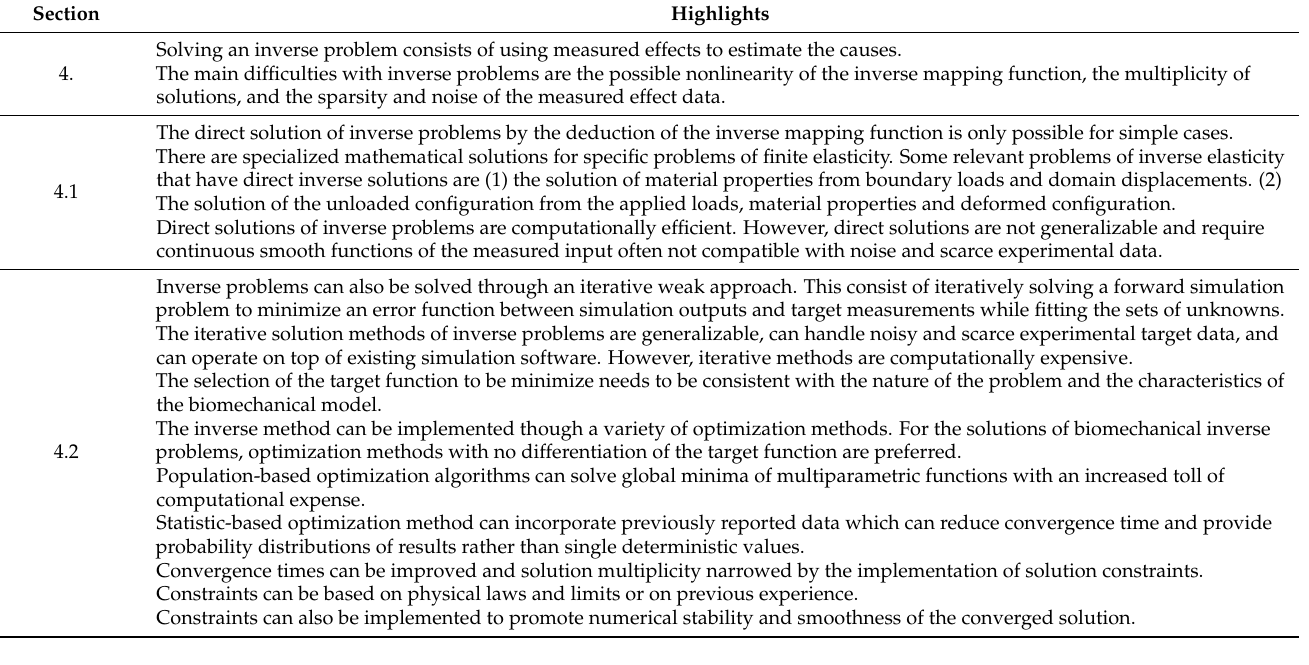
Table 3. Summary of inverse